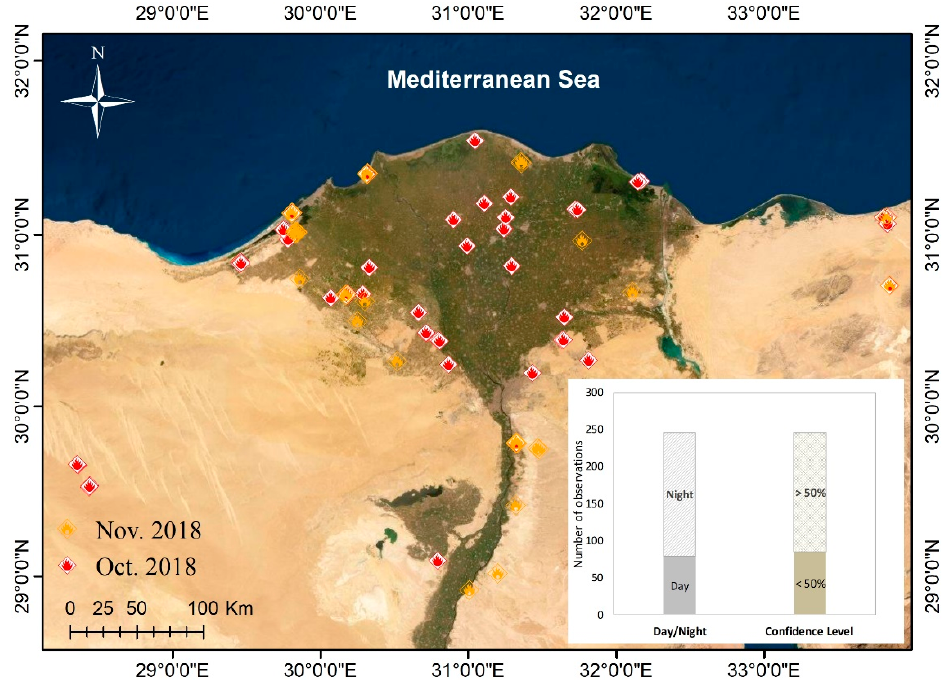
Figure 10. Observed fire spots over Egypt in Autumn (October and November 2018); the lower right plot presents the number of observed fires during the day and night and their confidence